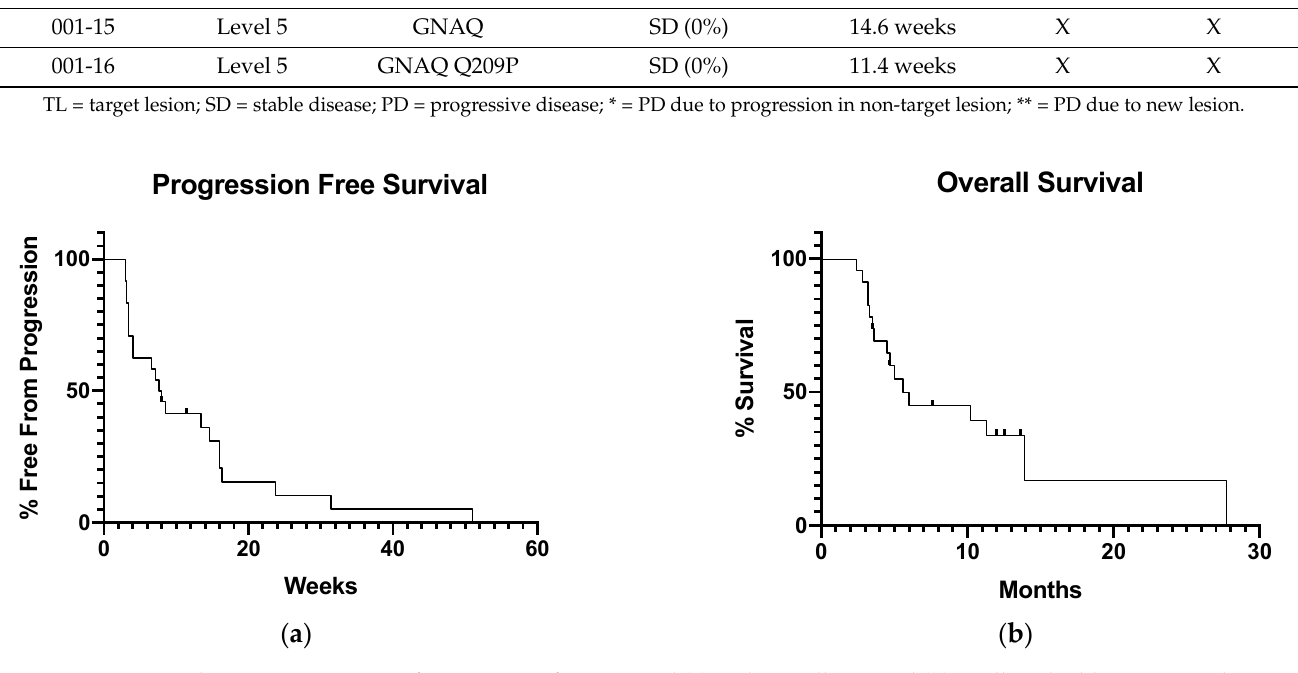
Figure A1. Kaplan-Meier estimates of progression-free survival ( a ) and overall survival ( b ) in all evaluable patients. The vertical lines indicate that patients’ data were censored. The median progression-free survival was 7.6 weeks (range, 3–51 weeks).The median overall survival was 6.0 months (range, 2.4–27.7 months).